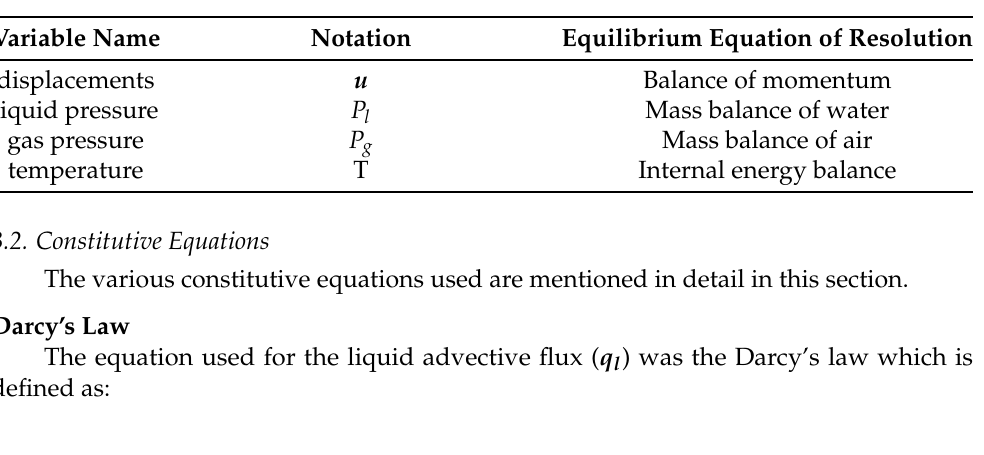
Table 2. Independent variables (unknowns)